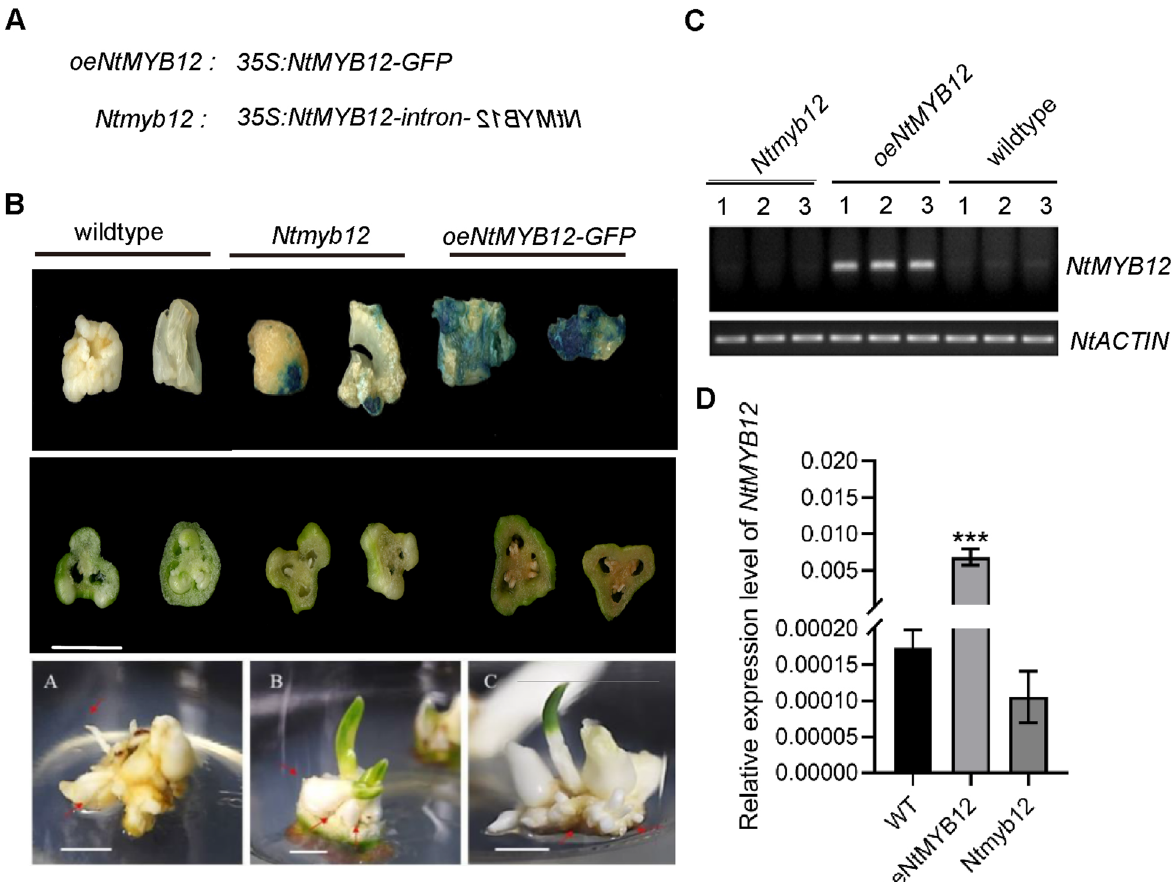
Fig. 2 Gain/Loss of NtMYB12 transgenic callus was generated and identified. A Scheme of gain/loss of NtMYB12 constructs; B overexpressing NtMYB12 and NtMYB12 RNAi transgenic bulbs ( Ntmyb12 ) were generated; Scale bars 1 cm; C Identification of transgenic tissues by semi-RT-qPCR, = NtACTIN gene was set up as an inner control; D Identification of transgenic bulbs by RT-qPCR. The error bar presented standard deviants of three biological replicates. Asterisk presents the statistical significance compared to WT (* p < 0.05; ** p < 0.01; *** p <